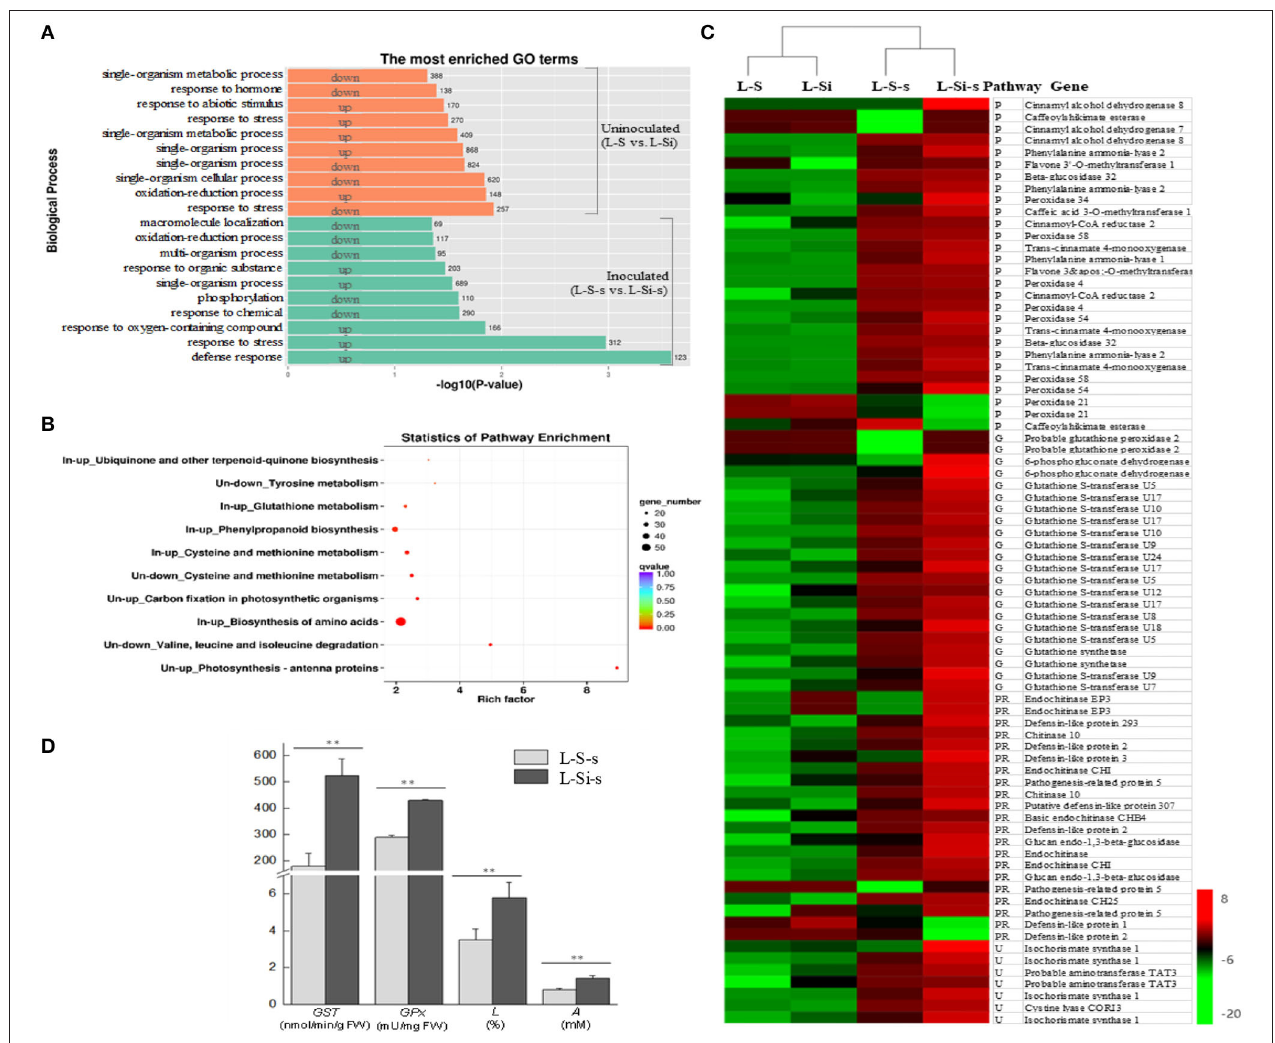
FIGURE 3 | Transcriptional differences of rapeseed leaves between K 2 SiO 3 and K 2 SO 4 treatments (K 2 SO 4 vs. K 2 SiO 3 ). (A) The most enriched Gene Ontology (GO) terms from the up- and downregulated differentially expressed genes (DEGs) in K 2 SiO 3 -treated leaves before inoculation (uninoculated) and at 24 hai (inoculated). The number on the right side of each bar indicates the number of DEGs. (B) Kyoto Encyclopedia of Genes and Genomes (KEGG) enrichments from the up- and downregulated DEGs in K 2 SiO 3 -treated leaves before inoculation (uninoculated, abbreviated as “Un” in the figure) and at 24 hai (inoculated, abbreviated as “In” in the figure). (C) Heatmap of interested genes in uninoculated and inoculated rapeseed leaves under K 2 SiO 3 and K 2 SO 4 treatments according to the reads per kilobyte per million mapped reads (RPKM) values. P, phenylpropanoid biosynthesis; G, glutathione metabolism; U, ubiquinone and other kinds of terpenoid-quinone